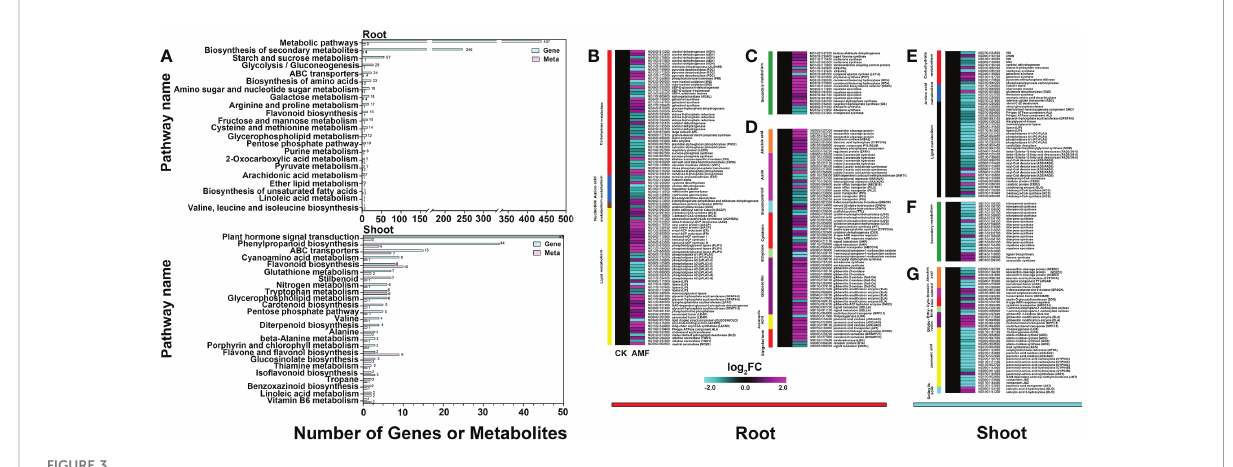
FIGURE 3 DEGs in root and shoot of apple plants inoculated with R . irregularis for 60 days (according to differential metabolites and MapMan). (A) Enrichment analysis of related differential genes and differential metabolites in root and shoot of transcriptome and metabolome. (B – D) , Differential genes related to metabolites in root, (B – D) with ninety-nine differential genes related to primary metabolites, twenty-one differential genes related to secondary metabolites, and seventy-three differential genes related to hormonal metabolites in root, respectively. (E – G) , Differential genes related to metabolites in shoot, (E) with forty-nine differential genes related to primary metabolites, (F) twenty differential genes related to secondary metabolites, and (G) forty-two differential genes related to hormonal metabolites in shoot. Expression-fold changes of DEGs (|log 2 FC| > 1, FDR < 0.05) were represented by color gradient from pink (induced) to blue